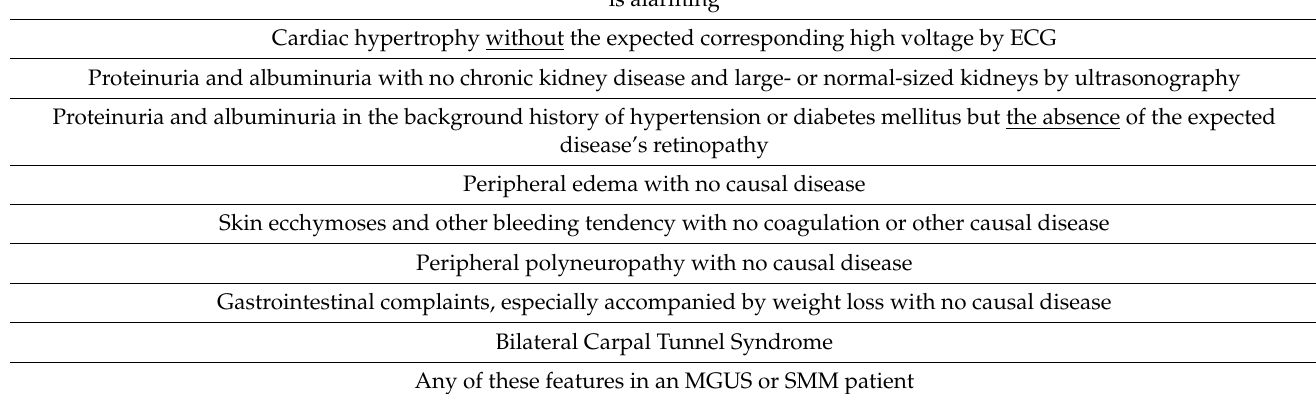
Table 1. Clinical features that must raise a suspicion of AL to the general and specializing